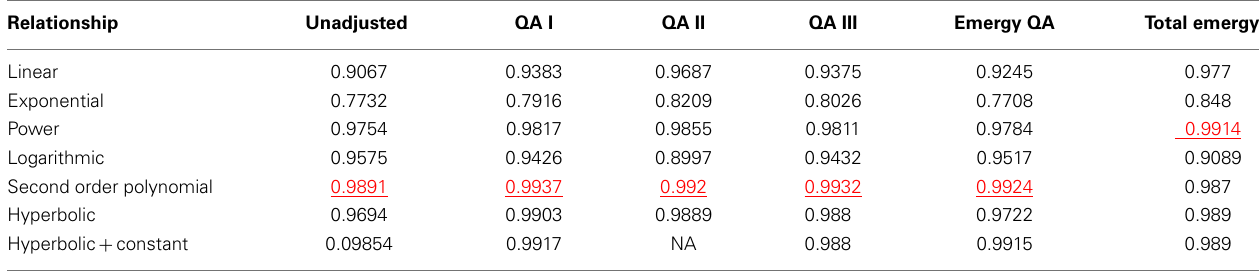
Table 6 |The R -squares of mathematical relationships between measures of energy and quality adjusted (QA) energy consumed or total emergy used (Y) and real GDP (X) .